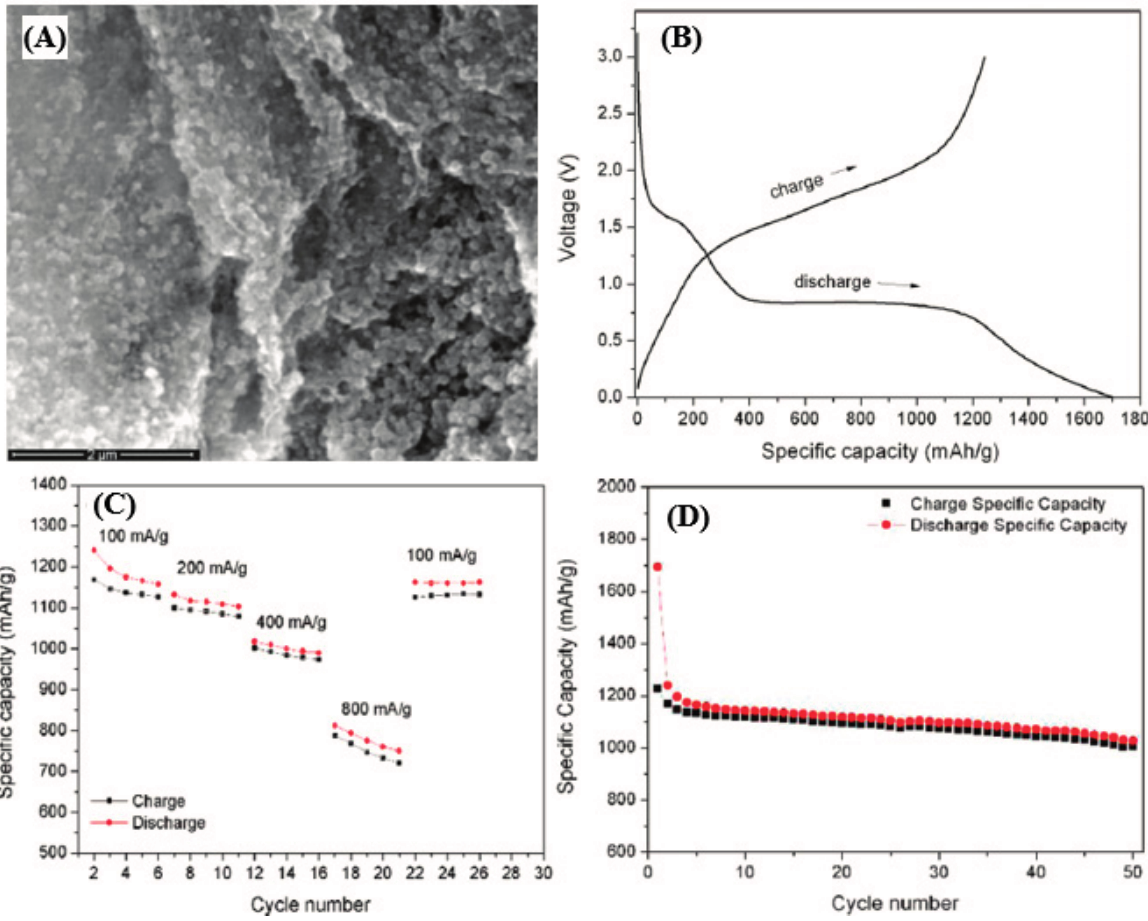
Figure 8. ( A ) SEM image of rGO/Fe 2 O 3 composites. ( B ) First discharge/charge profiles of rGO/Fe 2 O 3 composites for the first cycle at the current density of 100 mA/g. ( C ) Rate capacity of rGO/Fe 2 O 3 composites between 0.05 and 3.0 V with different current densities. ( D ) Cycling performance of rGO/Fe 2 O 3 composites at the current density of 100 mA/g. All the specific capacities are based on the mass of Fe 2 O 3 . Reproduced from [129] with permission from the American Chemical Society,